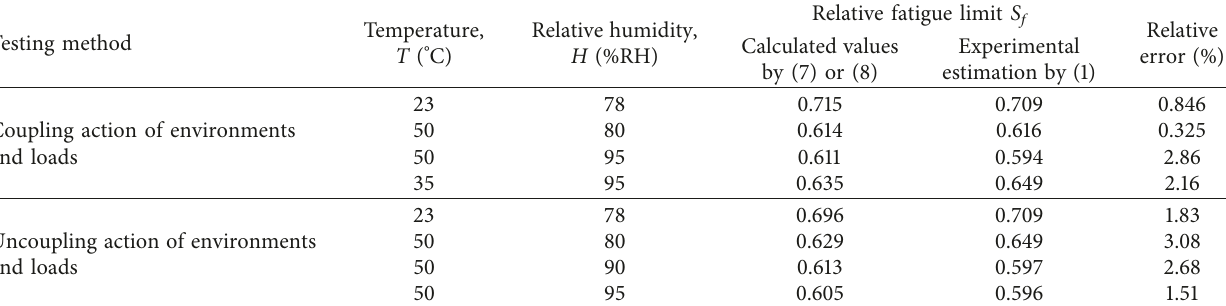
Table 6: Relative fatigue limits of SFPSC S